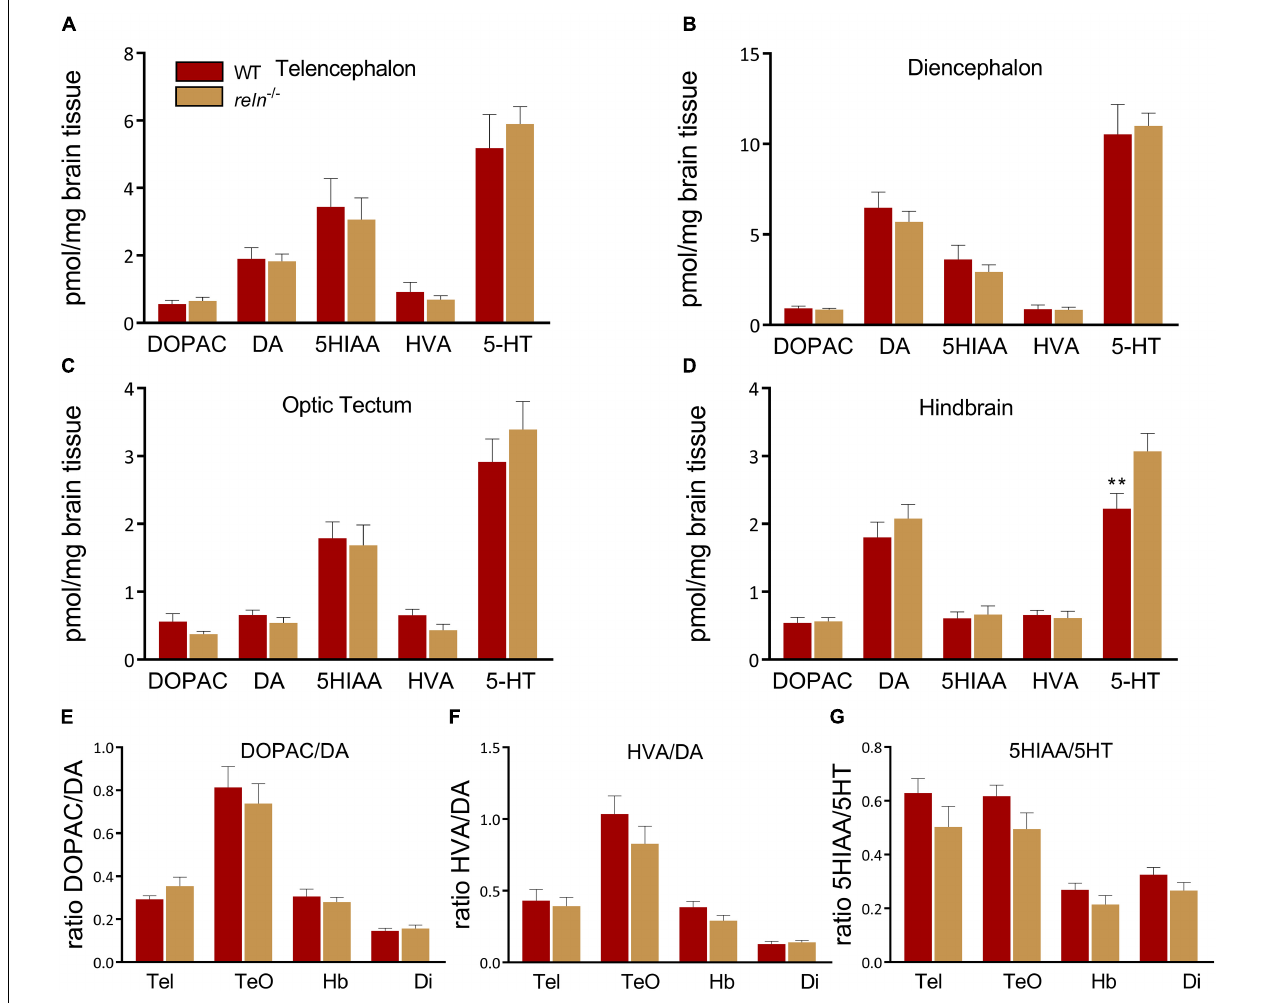
FIGURE 6 | High pressure liquid chromatography. 5-HT levels are increased in the hindbrain of reln − / − compared to WT [ t -test: t ( 3 . 694 ) = 70, p = 0.0021, multiple t -tests with Holm–Sidak multiple comparisons correction. n = 8 WT, n = 8 reln − / − ]. (A) Telencephalon, (B) diencephalon, (C) optic tectum and (D) hindbrain. No differences in the breakdown of (E) DOPAC/DA, (F) HVA/DA, (G) 5-HIAA/-5HT. DA, dopamine; Di, diencephalon; DOPAC, 3,4-Dihydroxyphenylacetic acid; Hb, Hindbrain; HVA, homovanillic acid; Tel, telencephalon; TeO, optic tectum; 5-HIAA, 5-hydroxyindoleacetic acid; 5-HT, 5-hydroxytryptamine. ∗∗ p < 0.01. Mean ±